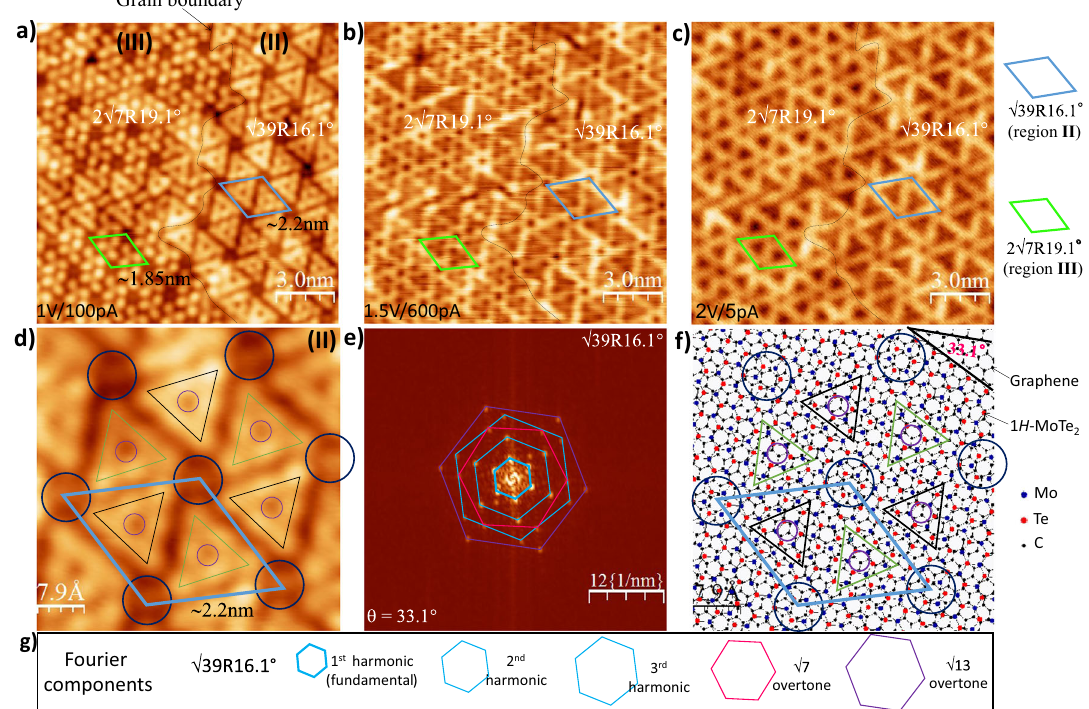
Fig. 4 STM images of the same 10 × 10 nm 2 scan area taken at the interface between (II) and (III) shown in Fig. 1c using different sample biases. a 1 V/100 pA, b 1.5 V/600 pA, c 2 V/5 pA; d Close-up STM image of the ~2.2 nm with triangular shapes inside of the Moiré supercell (blue rhombus), and e corresponding FFT image taken on ( d ), f Model lattices